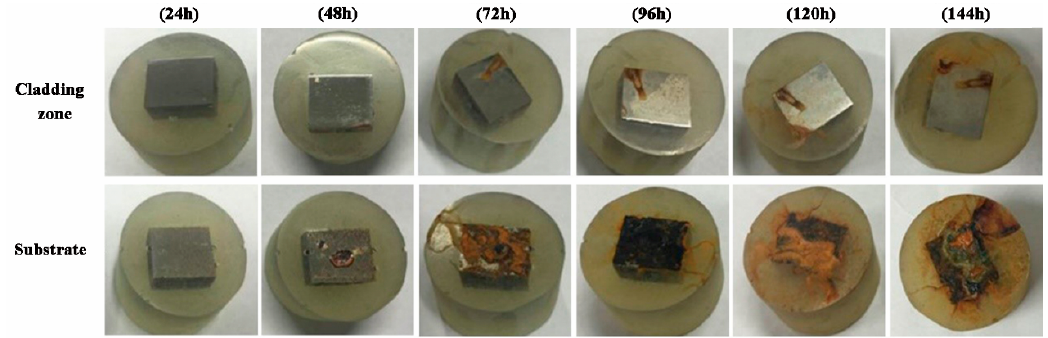
Figure 13. The surface macroscopic morphology of the CZ and S.